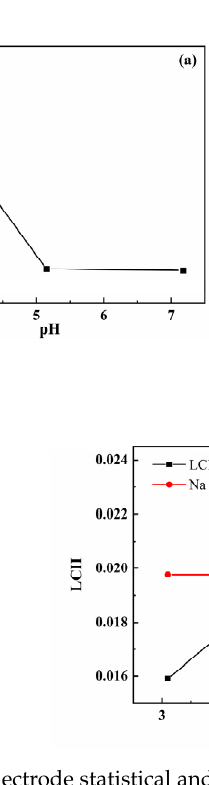
Figure 4. Potential ( E ) and galvanic current density ( i g ) distribution maps of WBE with S8-coating at different pH values (( a , b ): pH 3.10), (( c , d ): pH 5.15), (( e , f ): pH 7.18).